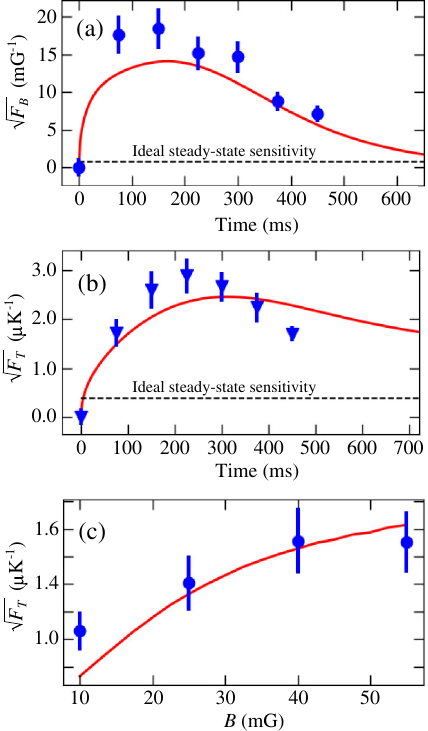
FIG. 5. Nonequilibrium boost of quantum-probe sensitivity. Time dependence of the magnetic sensitivity T ¼ 590 nK, centered at B ¼ 40 mG) (a) and thermal sensitivity ffiffiffiffiffiffi p F (for B ¼ 40 mG, centered at T ¼ 640 nK) (b) of the T quantum probe. Red lines correspond to theoretical calculations, blue dots or triangles are experimental data; dots are sensitivities extracted comparing only experimental populations, whereas triangles indicate sensitivities extracted comparing measured populations to theoretical ones. Dashed lines represent the respective sensitivity value expected for the steady state. (c) Ther- mal sensitivity (centered at T ¼ 640 nK) as a function of the B field for an interaction time that fixes the number of SE collisions to approximately